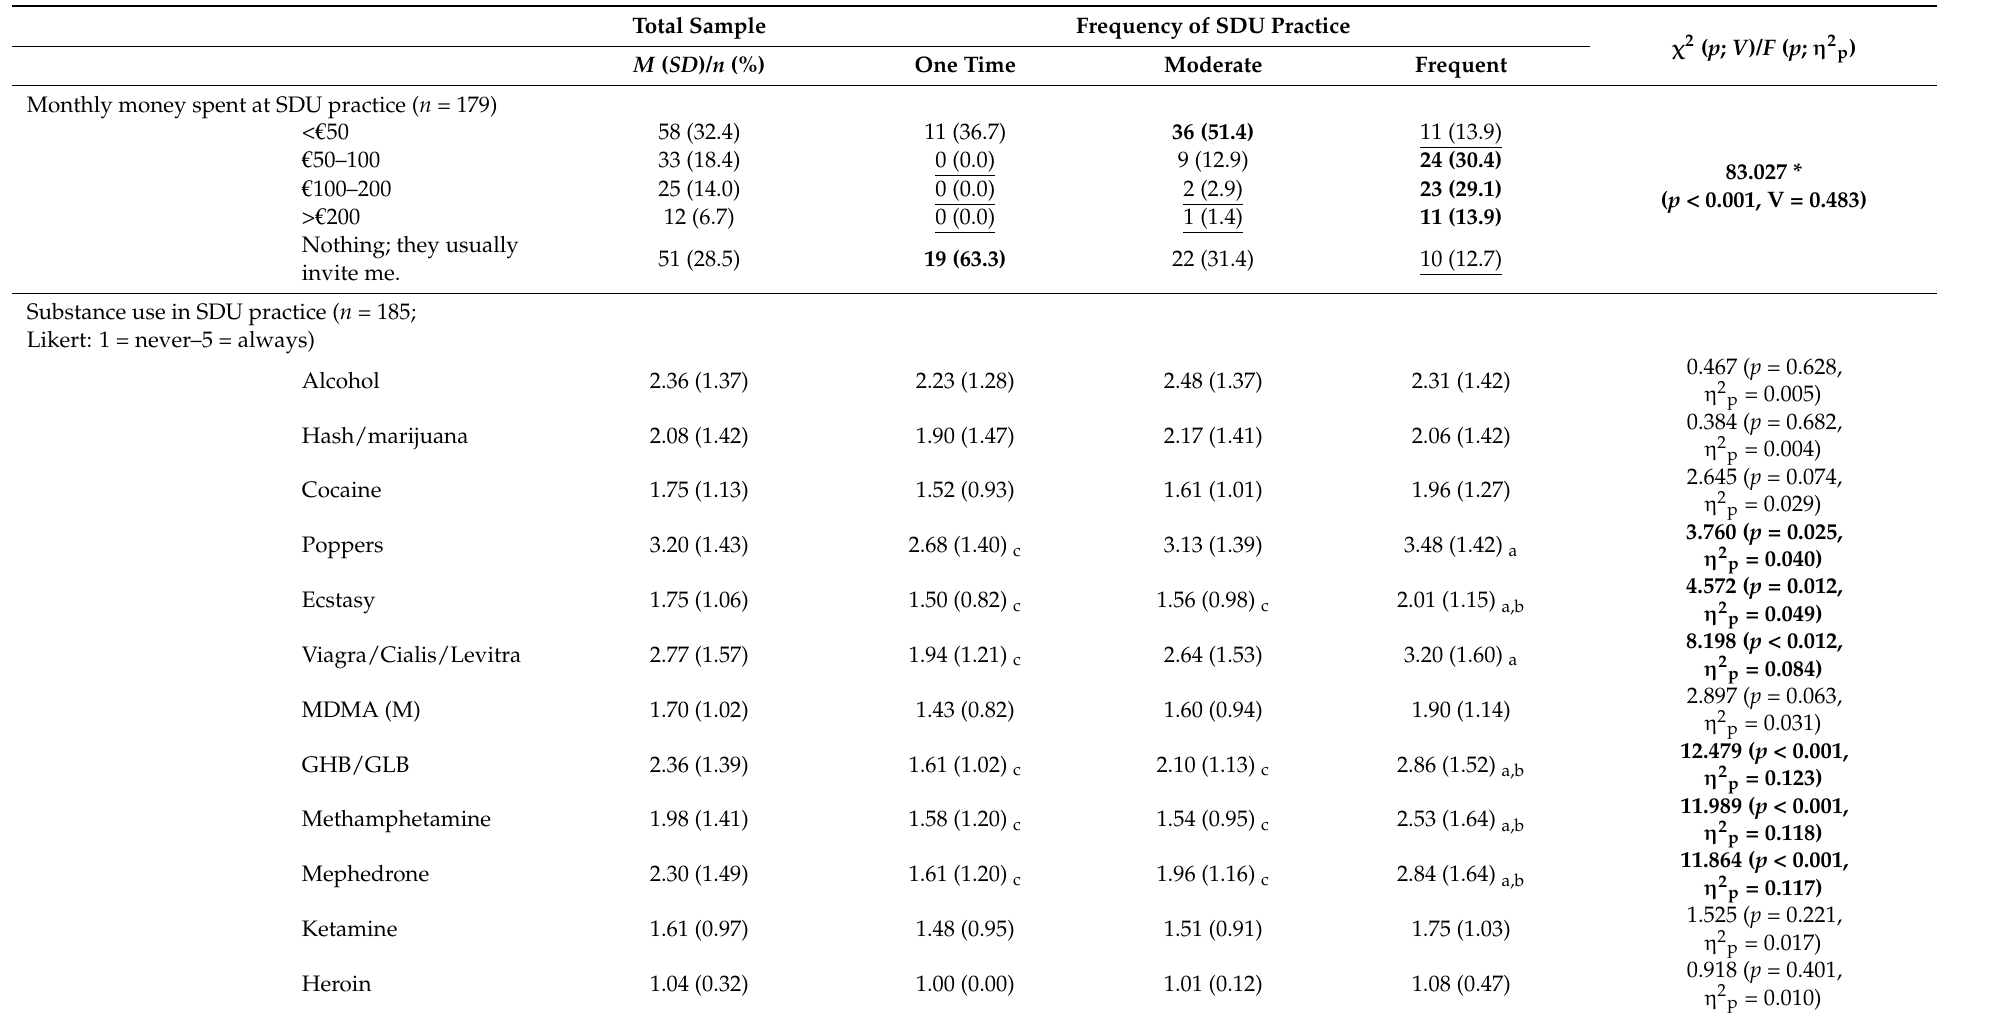
Table 1. Substances for